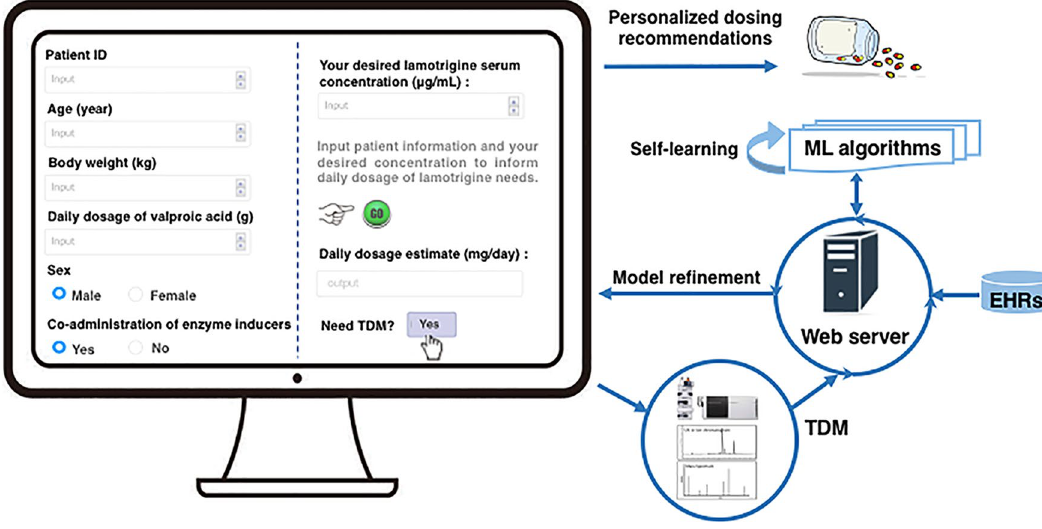
Figure 4. Web application to personalize dosing adjustments of lamotrigine, and the model’s self-learning and refinement processes. ML machine learning, TDM therapeutic drug-monitoring, EHRs electronic health